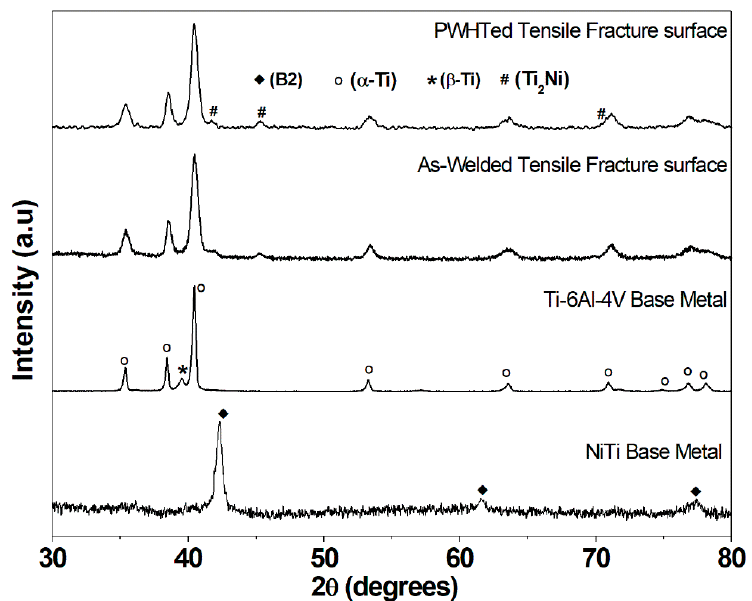
Figure 9. X-ray diffraction (XRD) profiles of the Ti-6Al-4V base metal, Nitinol base metal and fracture surface of the LFW welds in the as-welded and PWHT